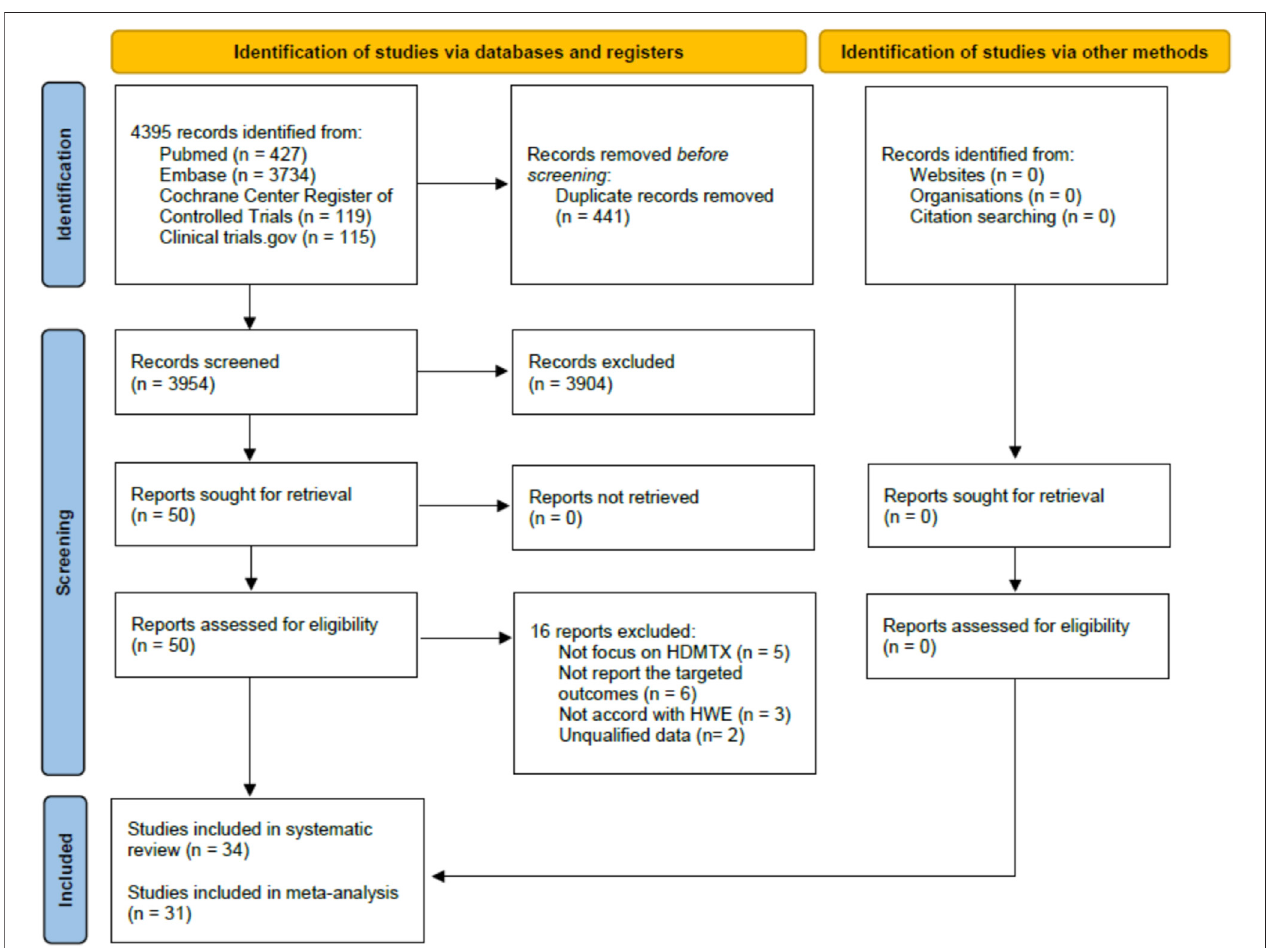
FIGURE 2 | PRISMA 2020 fl ow diagram of studies selection for the systematic review and meta-analysis.